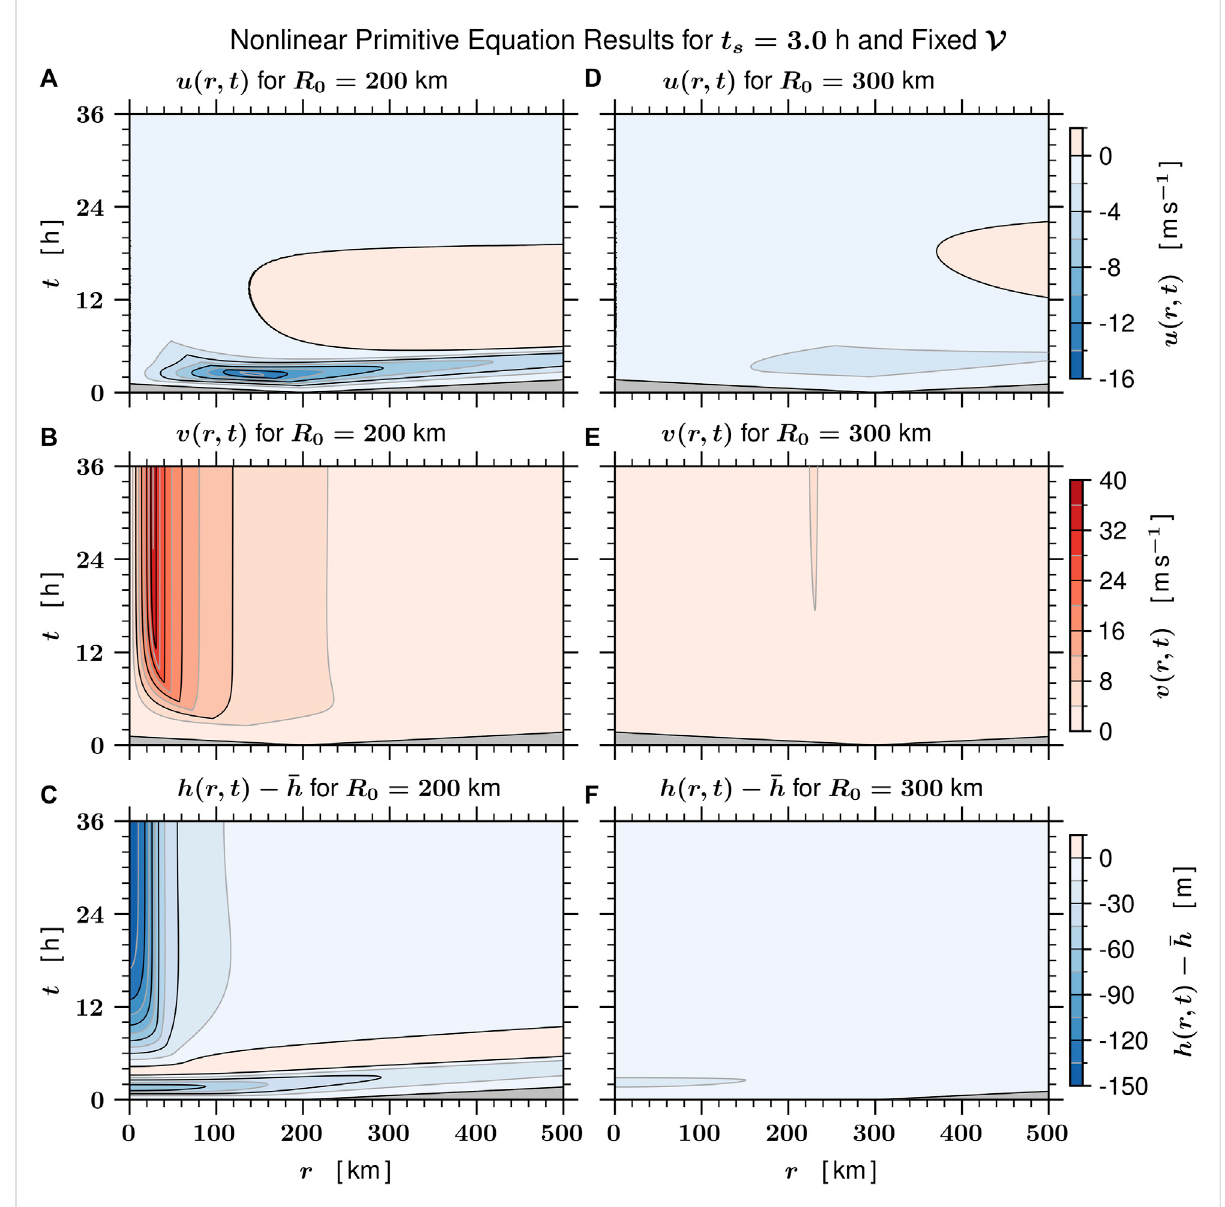
FIGURE 9 Panels (A – F) show the nonlinear primitive equation solutions obtained from Eq. 1 for the radial fl ow u ( r , t ), the azimuthal fl ow v ( r , t ), and the deviation depth h ( r , t ) − (cid:1) h for the forcing in Eq. 27 with t s =3 h. Panels (A-C) use the parameters R 0 =200 km and ϵ =0.99, while panels (D-F) use (cid:1) h ϵ , the same volume of fl uid is removed in each case. For the ϵ =0.44 case shown in (D-F) , the maximum R ϵ =0.44. Since V (cid:2) π R 2 0 =300 km and 0 azimuthalwindsareonlyabout4 m s − 1 ,whileforthe ϵ =0.99caseshownin (A-C) ,themaximumazimuthalwindsincreasetohurricanestrength. The gray regions indicate initial regions where the plotted fi eld is